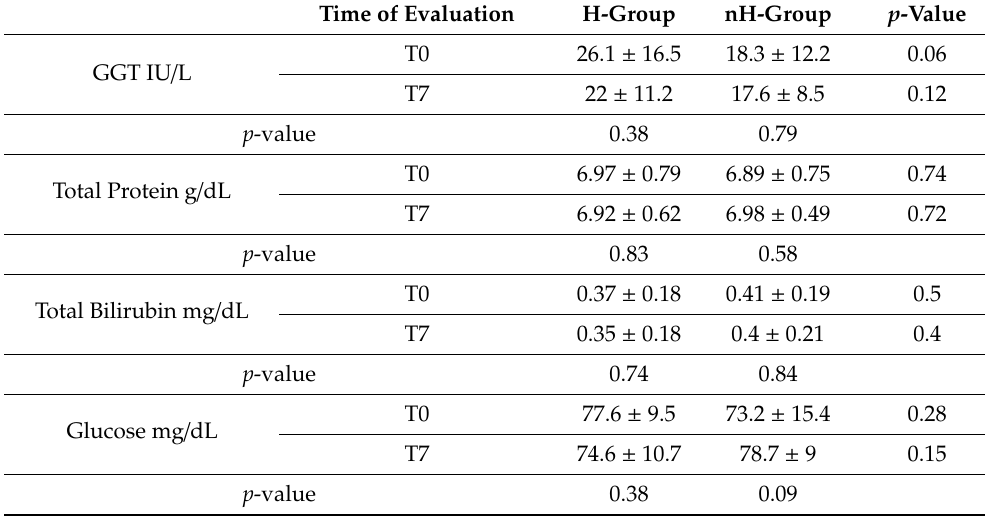
Table 3. Other laboratory parameters in 48 HFI patients distinguished in HFI patients with (H-group) and without (nH-group) persistent hypertransaminasemia, at diagnosis and at the end of follow-up. T0: time of diagnosis; T7: end of